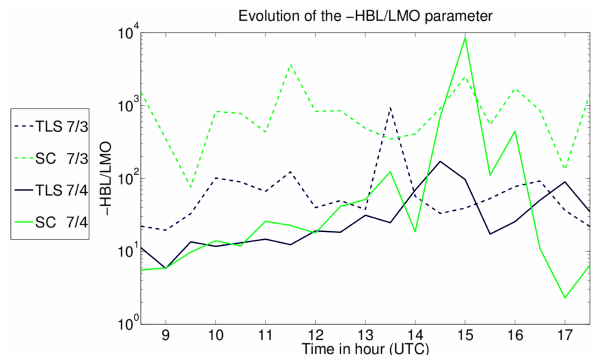
Fig. 8. Evolution of -HBL/LMO parameter observed over two sites: Toulouse downtown (TLS) and Saint-Sardos (SC) during the two days of the Fig.8. Evolutionof-HBL/LMOparameterobservedovertwosites: Toulousedowntown(TLS)andSaint-Sardos(SC)duringthetwodays oftheIOP